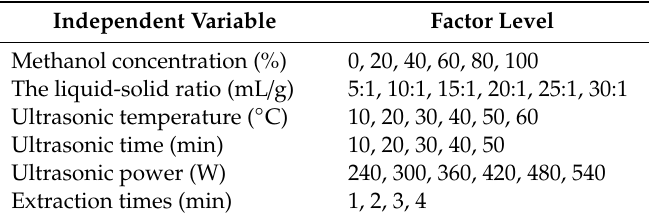
Table 2. Design of single factor experiment.